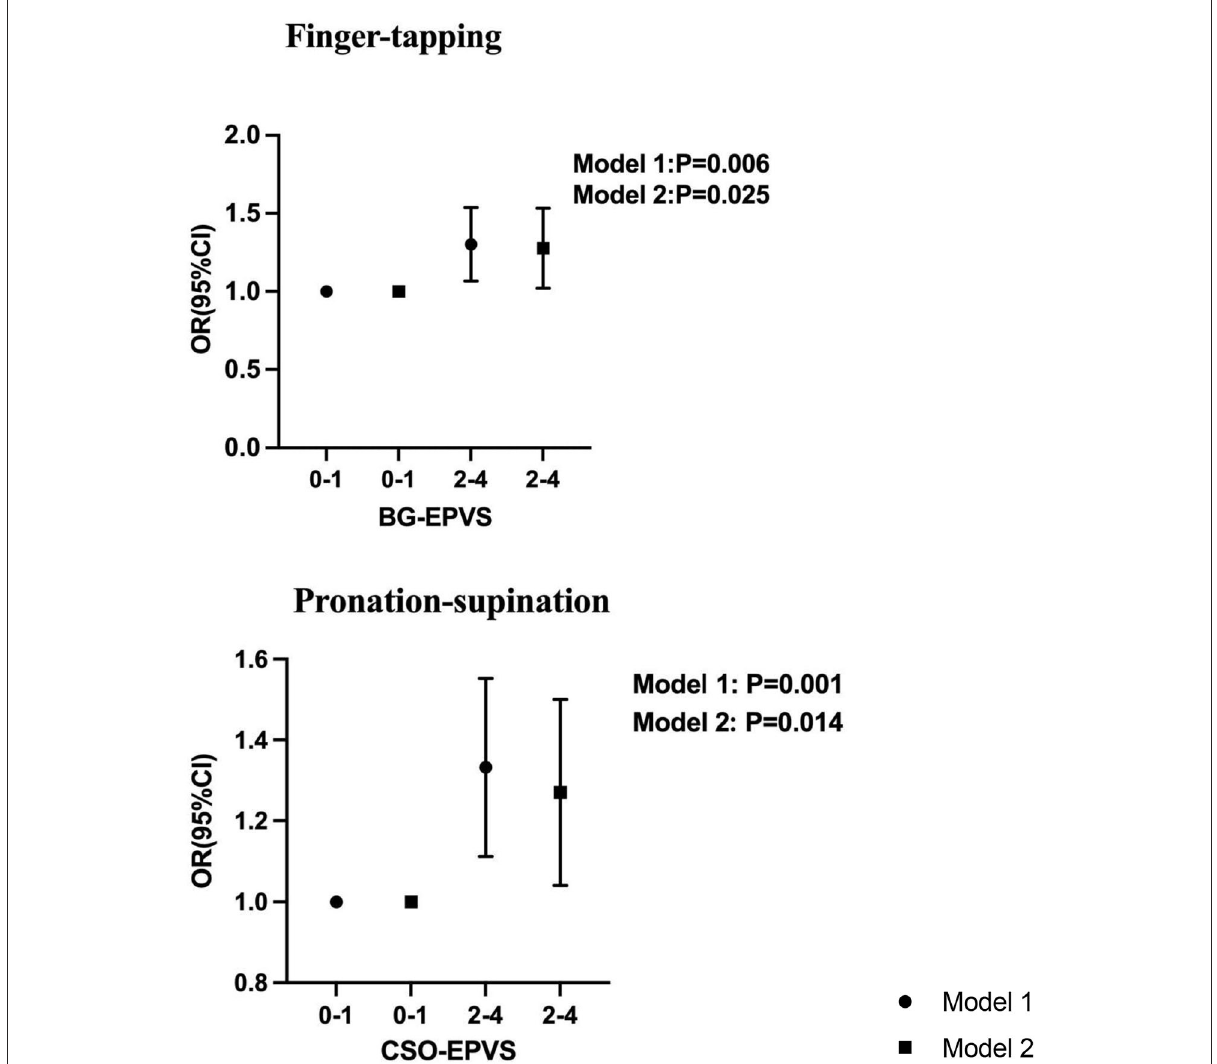
FIGURE1 Association between BG-EPVS and CSO-EPVS and impaired upper extremity function by logistic regression. Model 1 was adjusted for age, sex, height, and BMI. Model 2 is with additional adjustment for hypertension, diabetes, hyperlipidemia, neutrophil, hemoglobin, Fazekas score, the present of lacunar, brain atrophy, and